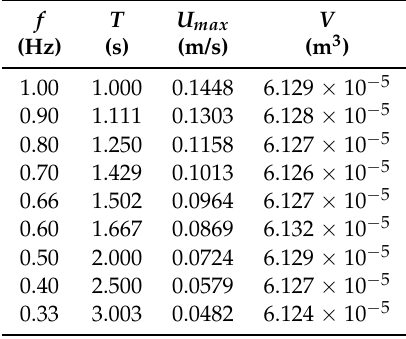
Table 2. Velocities used for the parametric